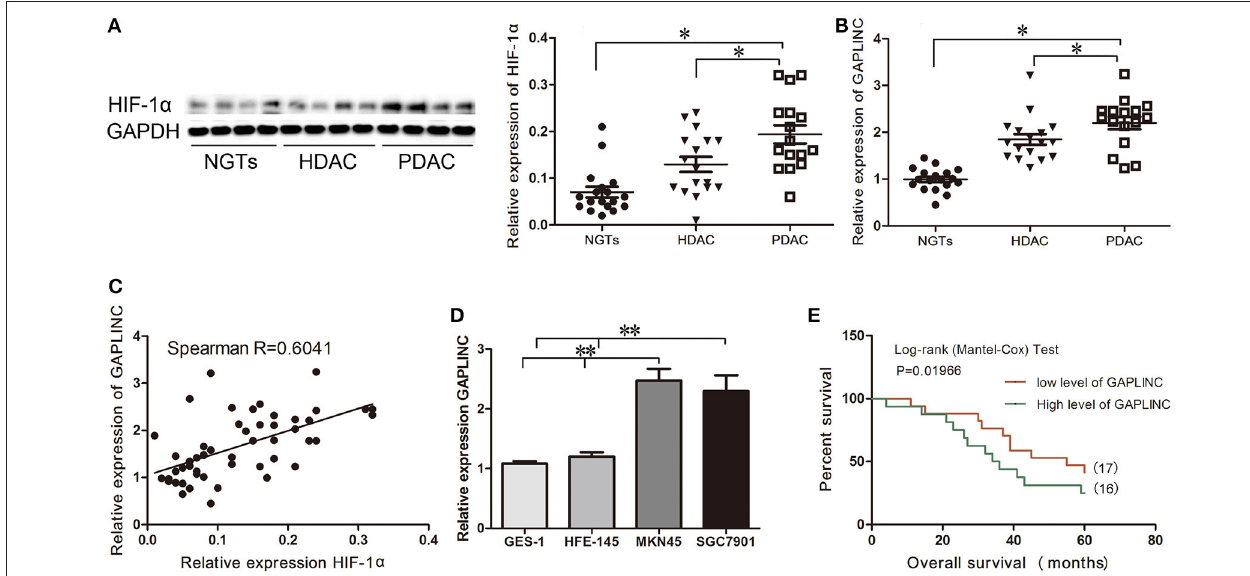
FIGURE 1 | Correlation between HIF-1 α protein expression and GAPLINC expression. GAPLINC overexpression was associated with adverse clinical outcomes in patients with gastric cancer (GC). Data represent the mean ± SD. (A) HIF-1 α was highly expressed in human gastric tissues ( n = 3 each group). (B) The endogenous expression of GAPLINC was determined by qRT-PCR in control gastric tissues, highly differentiated gastric adenocarcinoma tissues, and poorly differentiated gastric adenocarcinoma tissues. (C) Spearman correlation between HIF-1 α protein expression and GAPLINC expression ( R = 0.6041). (D) GAPLINC was highly expressed in GCcell lines compared to normal gastric mucosa cell lines. (E) Overall survival (OS) of patients with GAPLINC-low expression (17 cases) and high expression (16 cases). GAPLINC expressions were normalized to the ratios of expressions in tissues to one specimen picked randomly in NGTs (ranged from 1.23 to 3.24, and the cut off point was 2.03). The Mantel-Cox test was used to compare OS after surgery. The GAPLINC-low expression group had longer OS (* P < 0.05, ** P < 0.01).